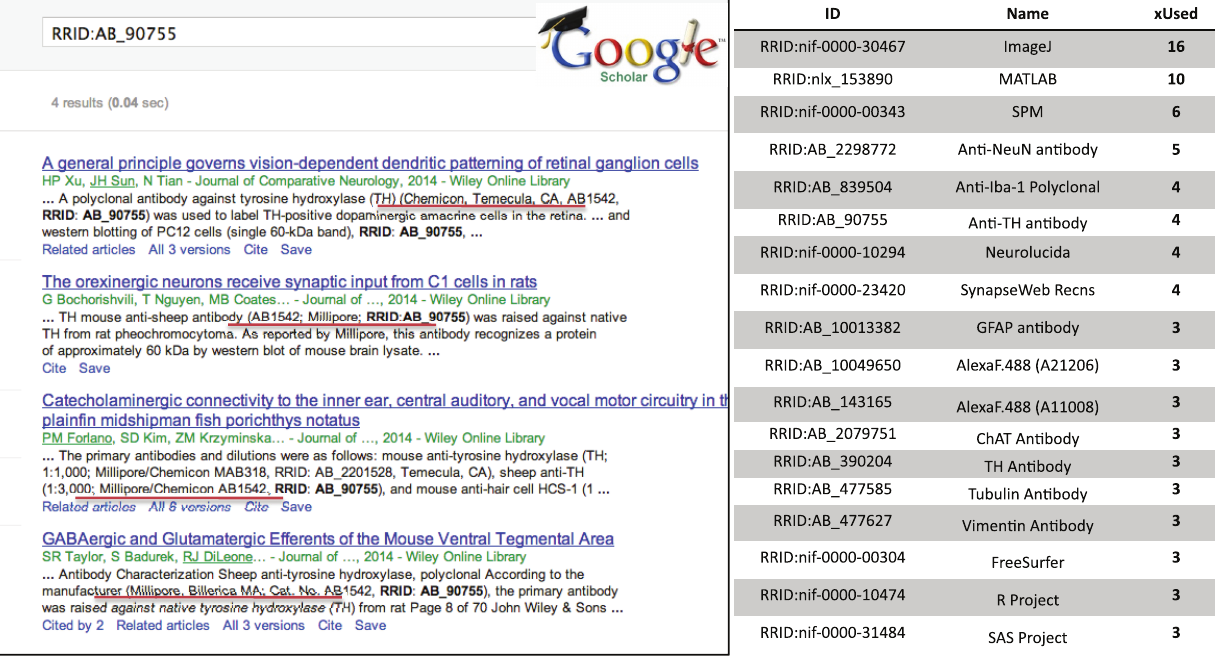
Figure 2. RRIDs found in the published literature. A . Google Scholar result for the anti-tyrosine hydroxylase antibody RRID (9/2014; http:// scholar.google.com/scholar?q=RRID:AB_90755). B . The most frequently reported RRIDs in the first 100 papers, by number of papers using the identifier. All data is available in the Supplementary Table and all identifiers can be accessed in Google